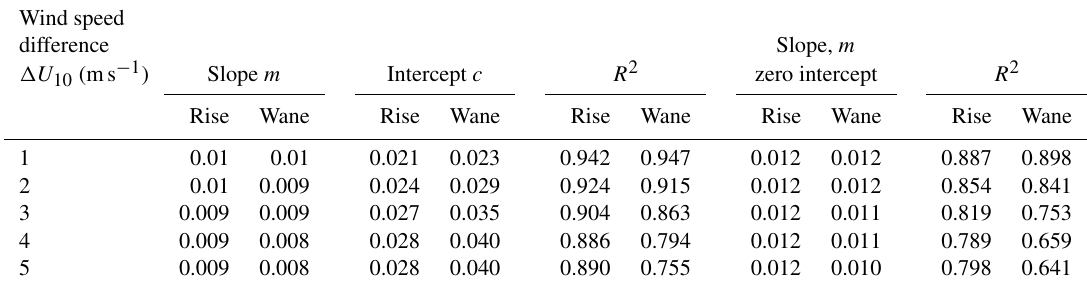
Table 3. Regression coefficients m (slope) and c (intercept) derived by fitting Eq. (8b) to subsets of W data associated with rising and waning (increasing and decreasing) wind speeds (a proxy analysis for wave field development). Different wind speed differences (cid:49)U 10 , determined from ECMWF wind speed values, were used to select W data for rising or waning winds. Also given is the coefficient m (slope) for a fit forced though zero (intercept c = 0). Coefficients of determination R 2 are also